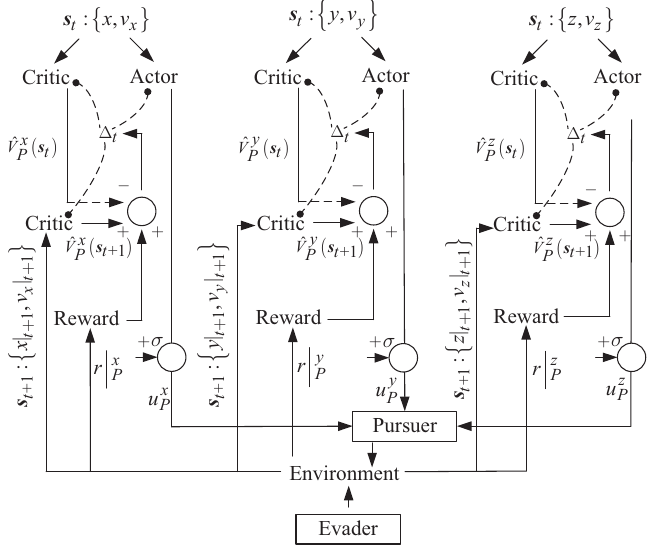
Figure 3. The diagram of the learning